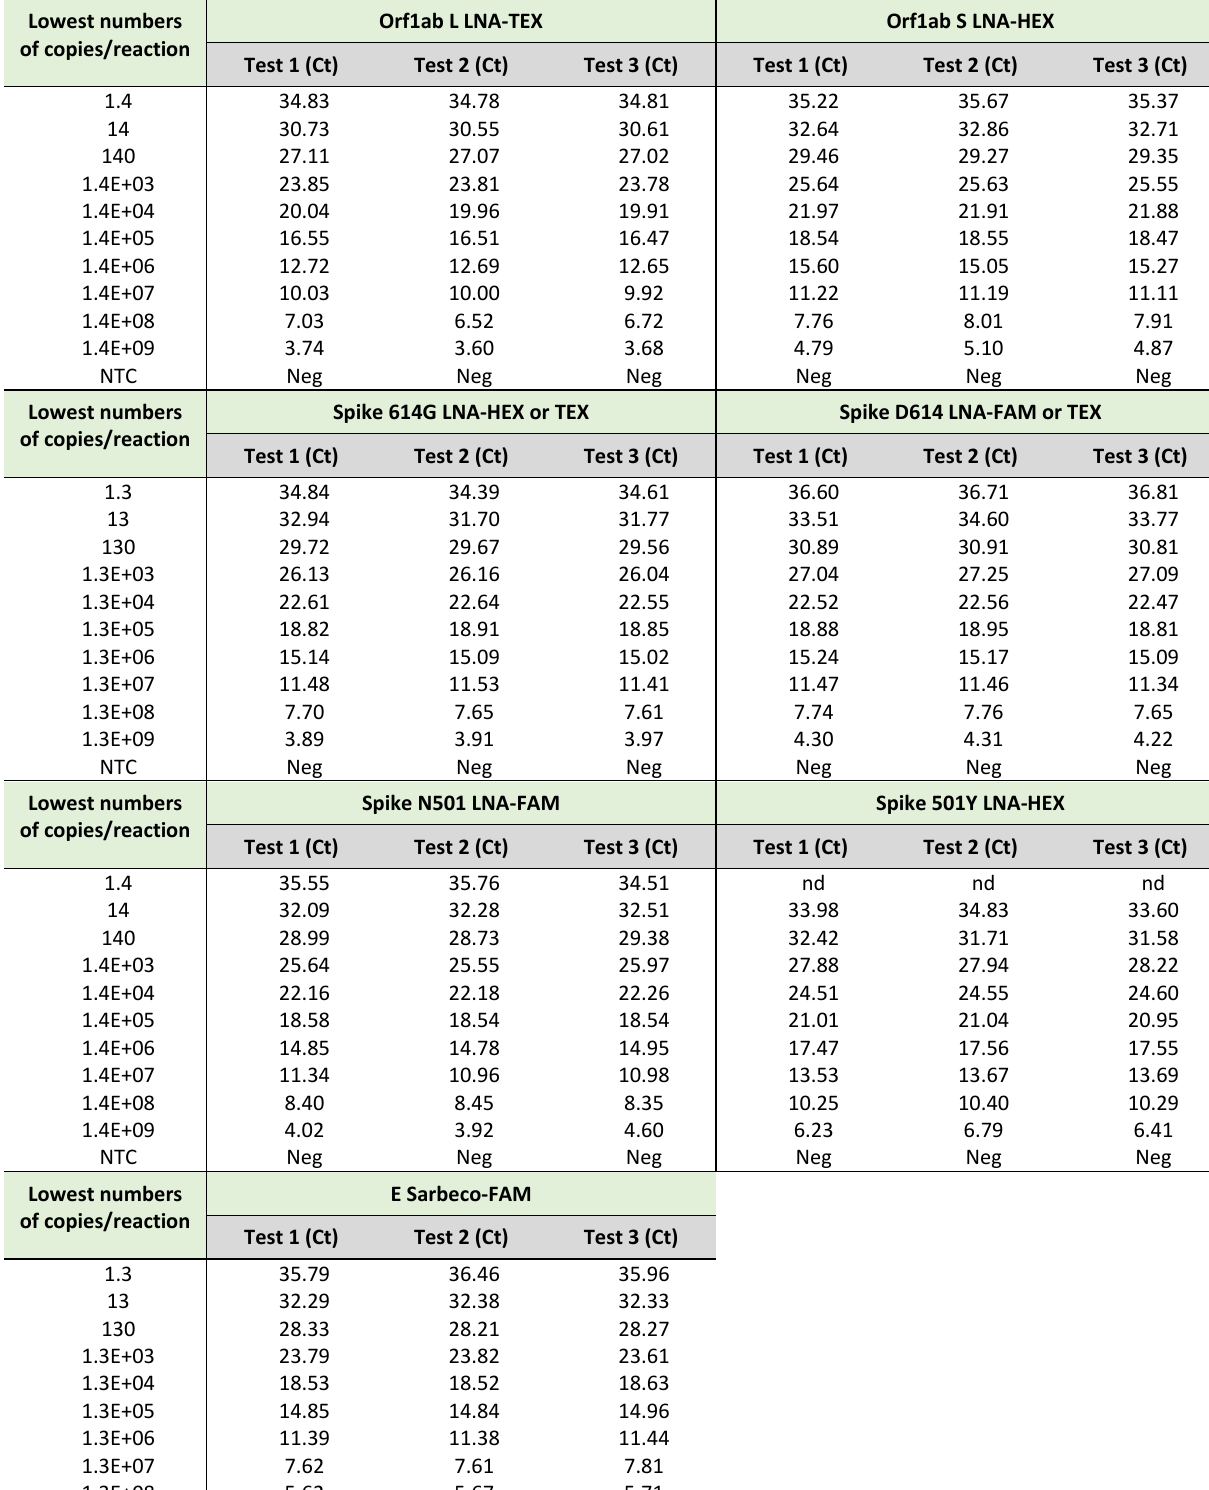
TABLE 2. Limits of detection of SARS-CoV-2-specific primers and probes using synthetic RNA transcripts in singleplex rRT-PCR